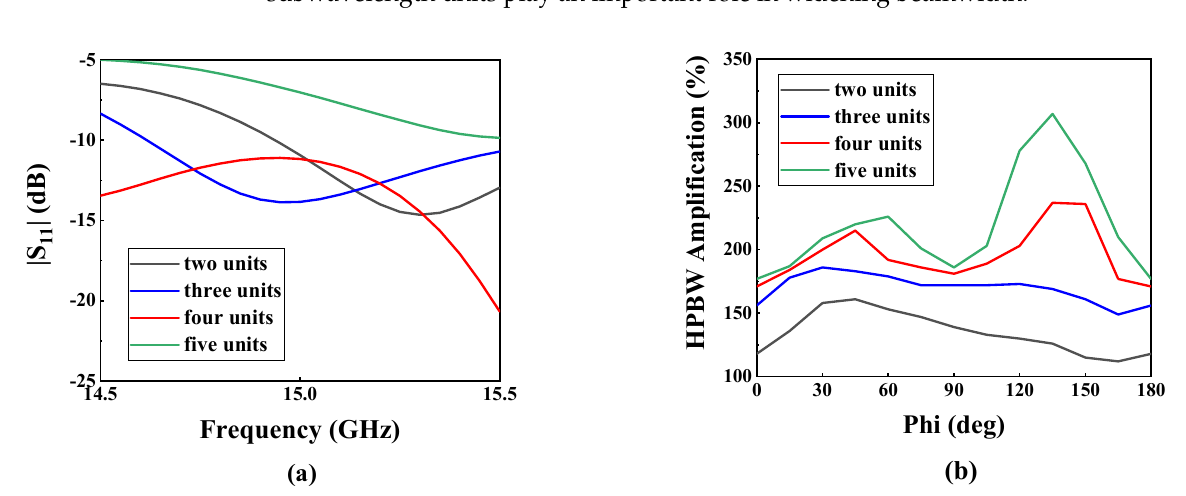
Figure 5. The performances of antennas with different numbers of subwavelength elements in each row. ( a ) |S 11 |. ( b ) The amplification of HPBW in all cut-planes.